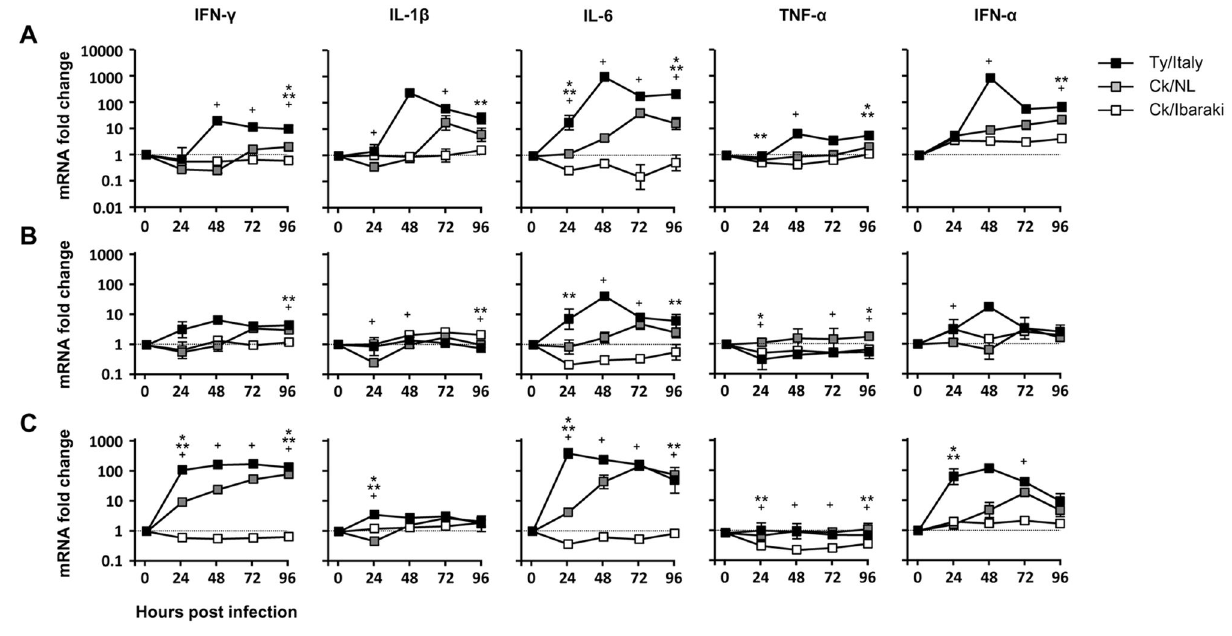
Figure 3. Comparison of cytokine mRNA expression. Tissues were collected from 3 chickens per group every 24 h after inoculation with 10 6.0 EID of HPAIVs or LPAIV, and cytokine mRNA expression in the brain ( A ), lungs ( B ), and spleen ( C ) was 50 analyzed using real-time PCR. Data are expressed as mean fold changes with standard errors relative to β-actin mRNA. Data of dead chickens was eliminated from the results. * p <0.05 between Ty/Italy and Ck/NL, ** p <0.05 between Ty/Italy and Ck/Ibaraki, + p <0.05 between Ck/NL and Ck/Ibaraki. doi: